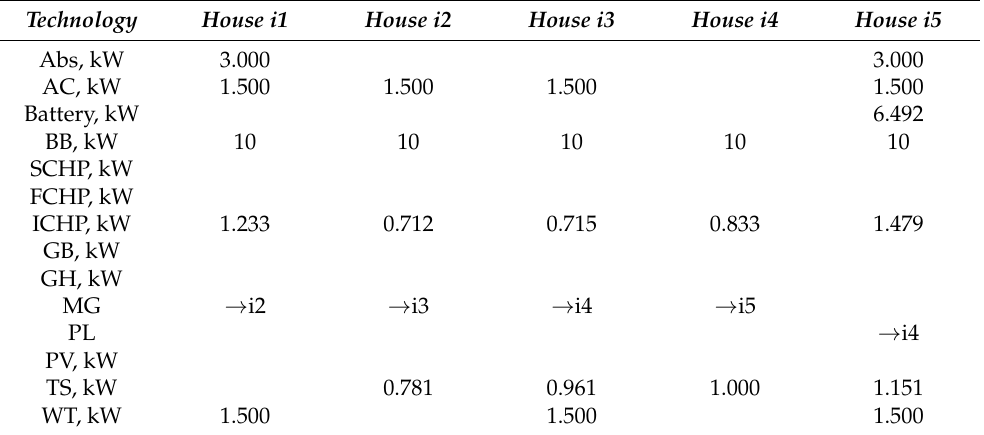
Table 10. Integrated DER technologies installations for the grid connected network with constant import